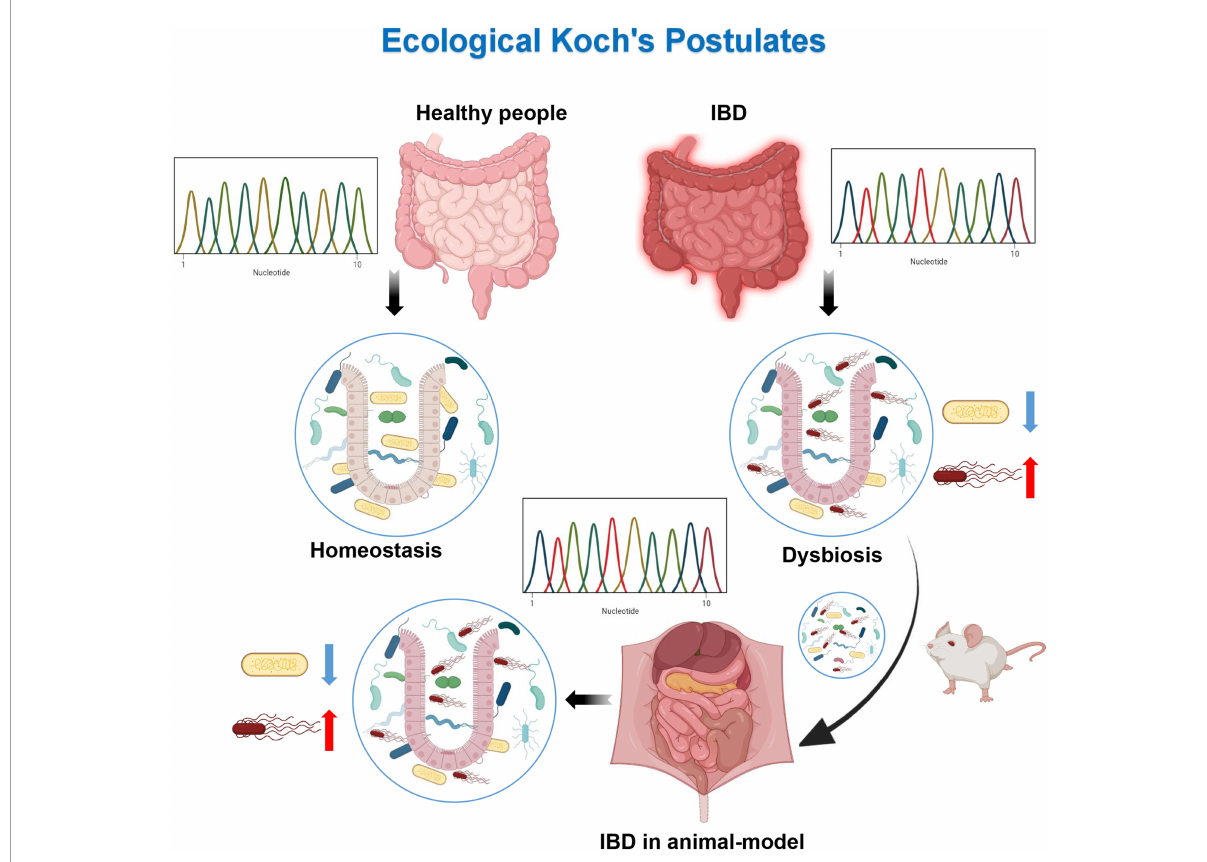
FIGURE2 Ecological Koch’s postulates. By sequencing healthy individuals and diseased patients, it has been found that their microflora are different. Dysbiosis of microflora can be obtained from the diseased patients. The dysbiosis of microflora can cause the same disease when introduced into a healthy host. The dysbiosis of microflora can be detected from the diseased